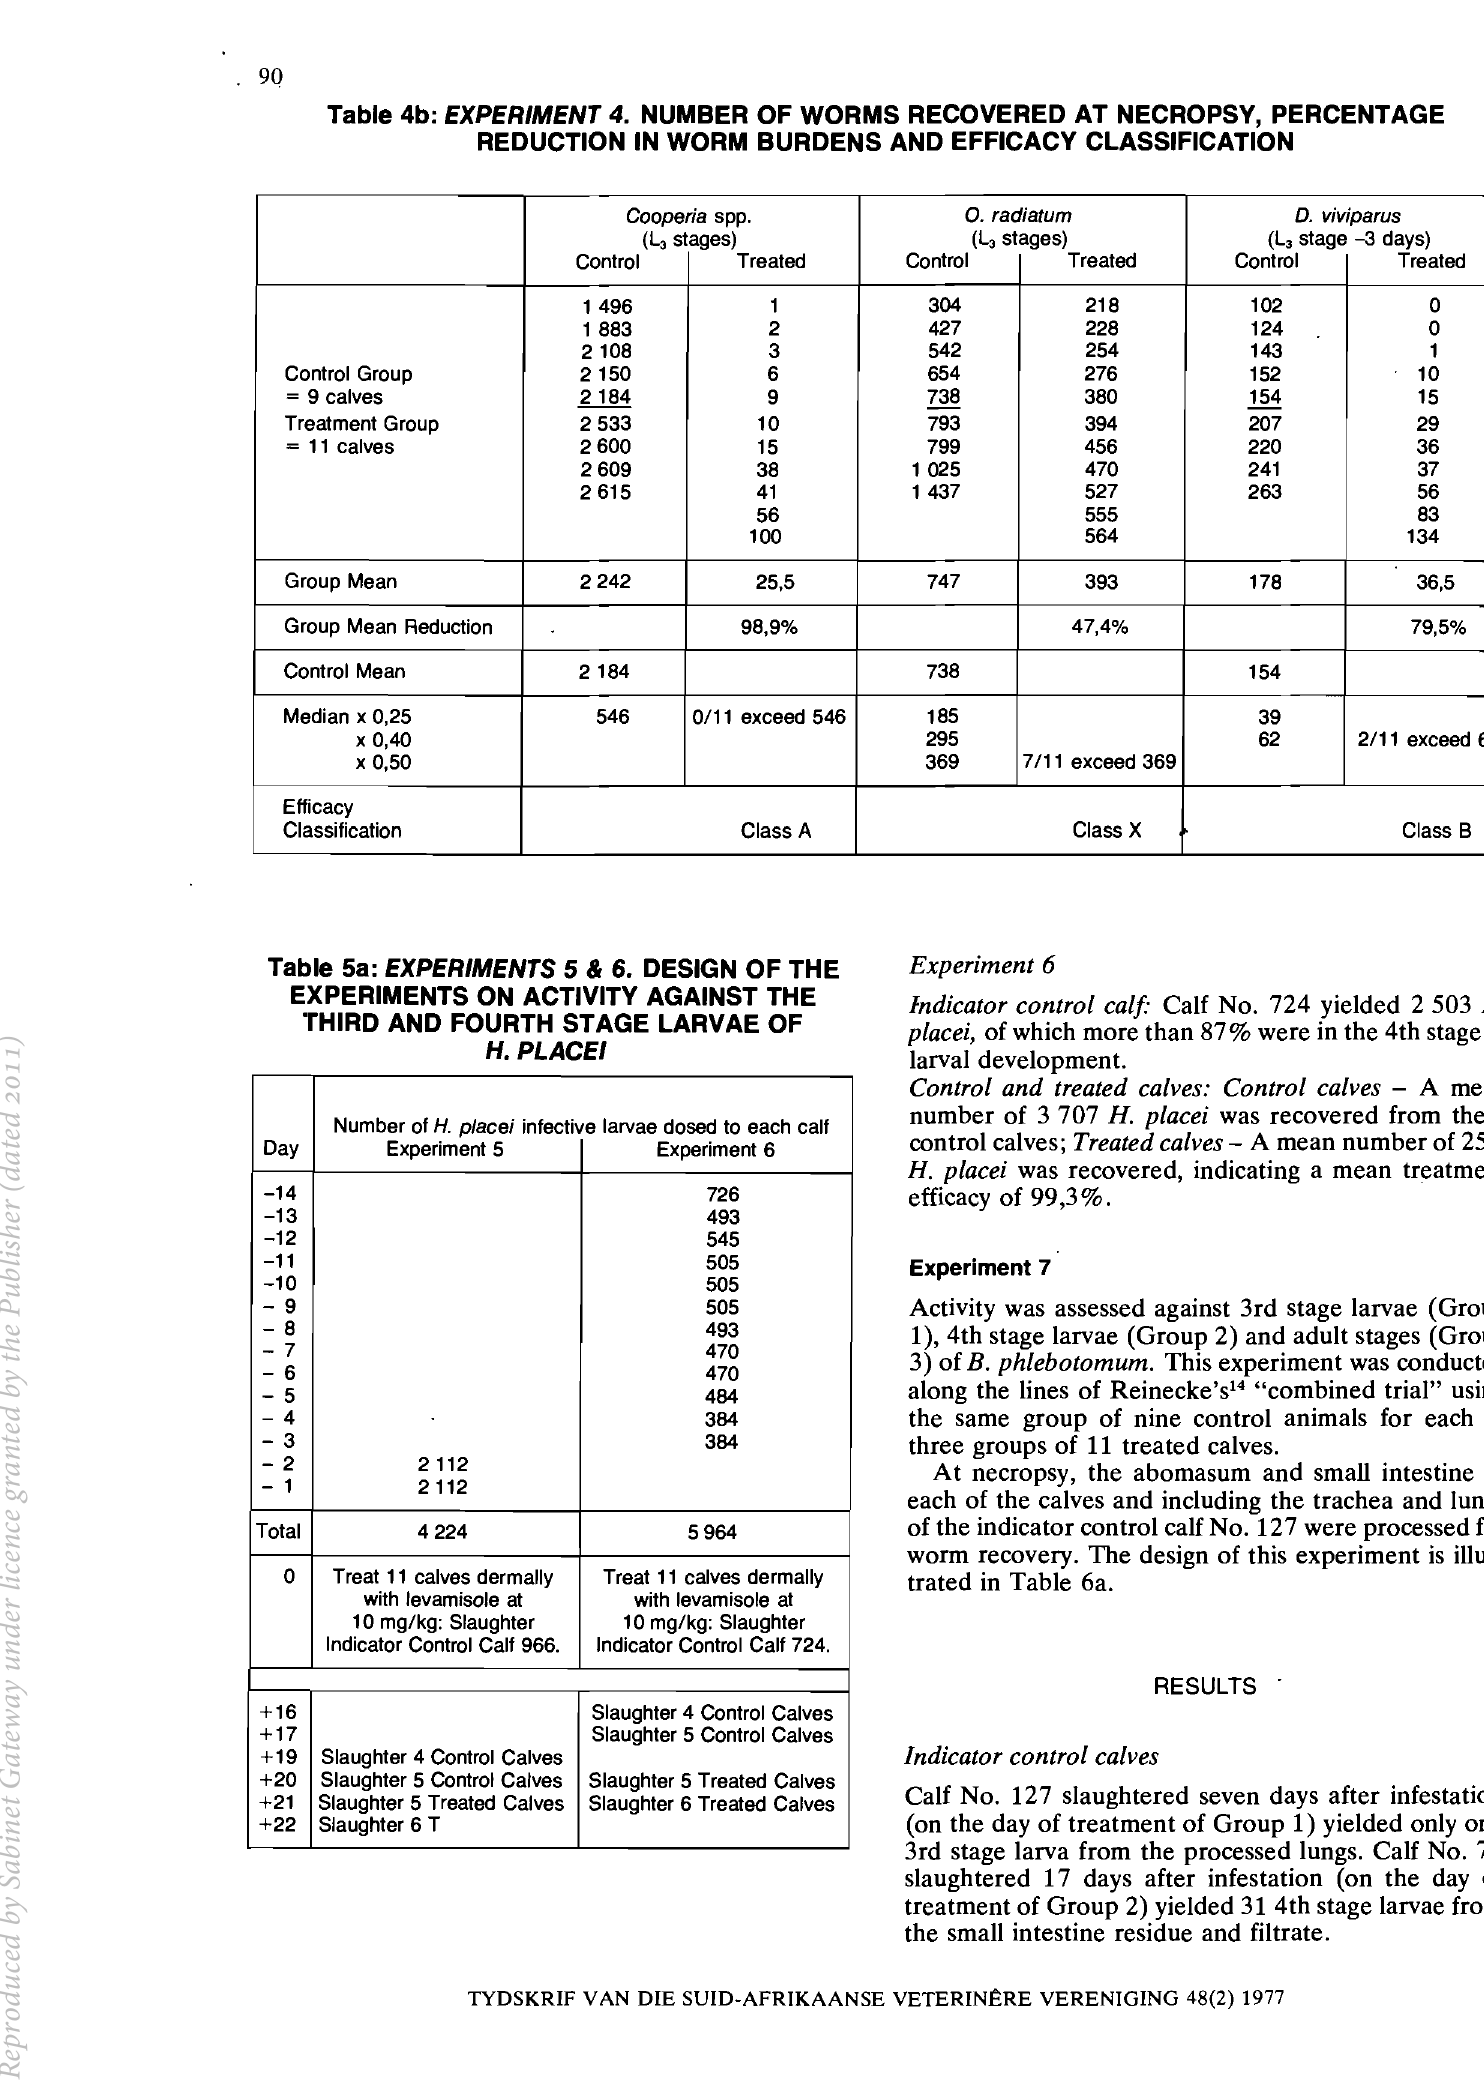
Table Sa: EXPERIMENTS 5 & 6. DESIGN OF THE EXPERIMENTS ON ACTIVITY AGAINST THE ·rHIRD AND FOURTH STAGE LARVAE OF H.